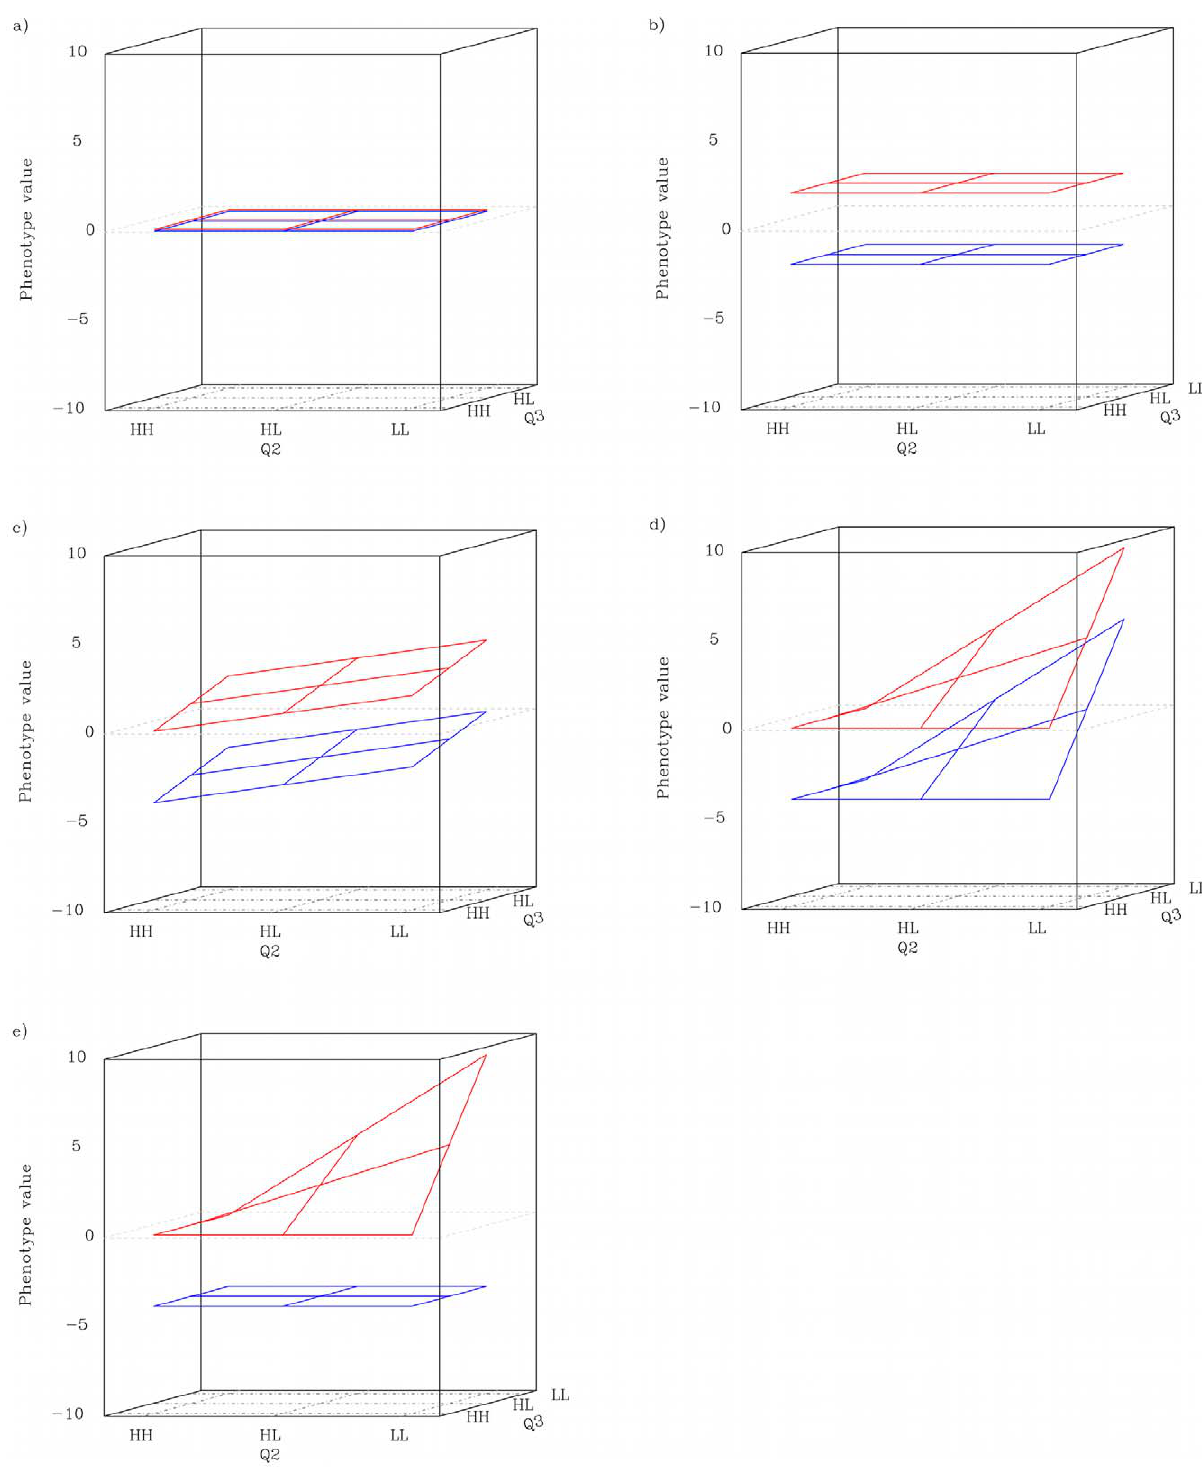
Figure 1. Schematic description of genotype-conditioned plane in different QTL patterns. a ): neither locus has any effect. b ): the conditioning locus has a main effect but no interactions. c ): all three loci have (non-interacting) main effects. d ): the conditioning locus has a capacitating effect, and the two other loci display synergistic epistasis in the HH background. The red and blue planes represent the HH and LL genotype classes at the conditioning locus, respectively. The phenotype scale is arbitrary.